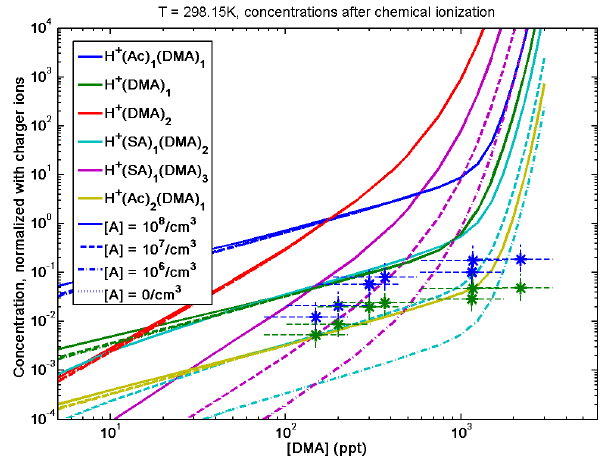
Figure 9. Modelled concentrations of charged clusters after chem- ical ionization, normalized with the remaining charger ion concen- tration after the ionization, ([H + (Ac) 1 ] + [H + (Ac) 2 ]). The stick- ing factor was 1 for all collisions, the neutral acetone monomer concentration was 10 9 cm − 3 , and the initial charger ion concen- tration was 10 6 cm − 3 . The stars represent the CI-APi-TOF mea- surement data, presented as the normalized average signals of ion counts per second. Green stars are for H + (DMA) 1 and blue stars are for H + (Ac) 1 (DMA) 1 . The error bars in the direction of the x axis are calculated using known sources of error and propagation of uncertainty. The error bars in the direction of the y axis represent the uncertainty in ion transmission